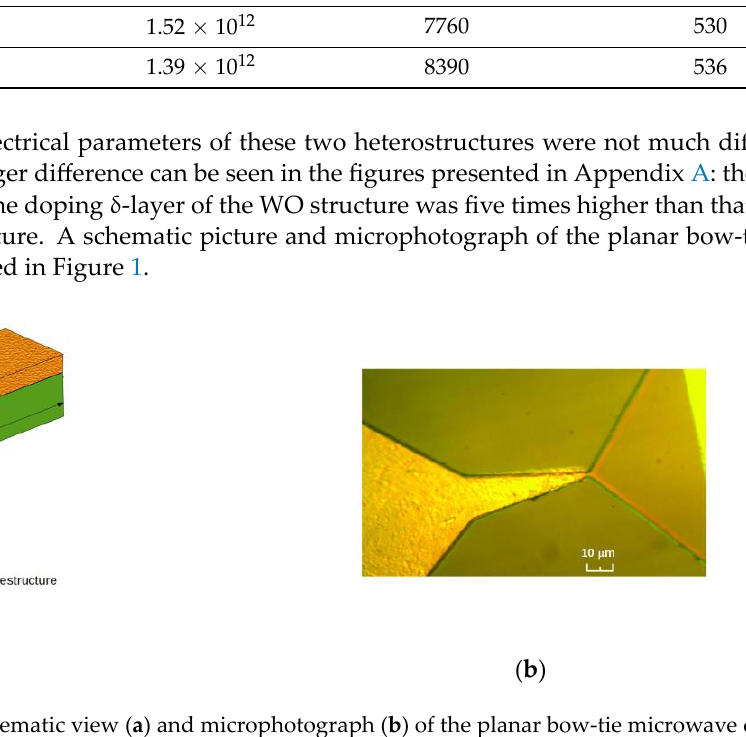
Figure 1. Schematic view ( a ) and microphotograph ( b ) of the planar bow-tie microwave diodes.